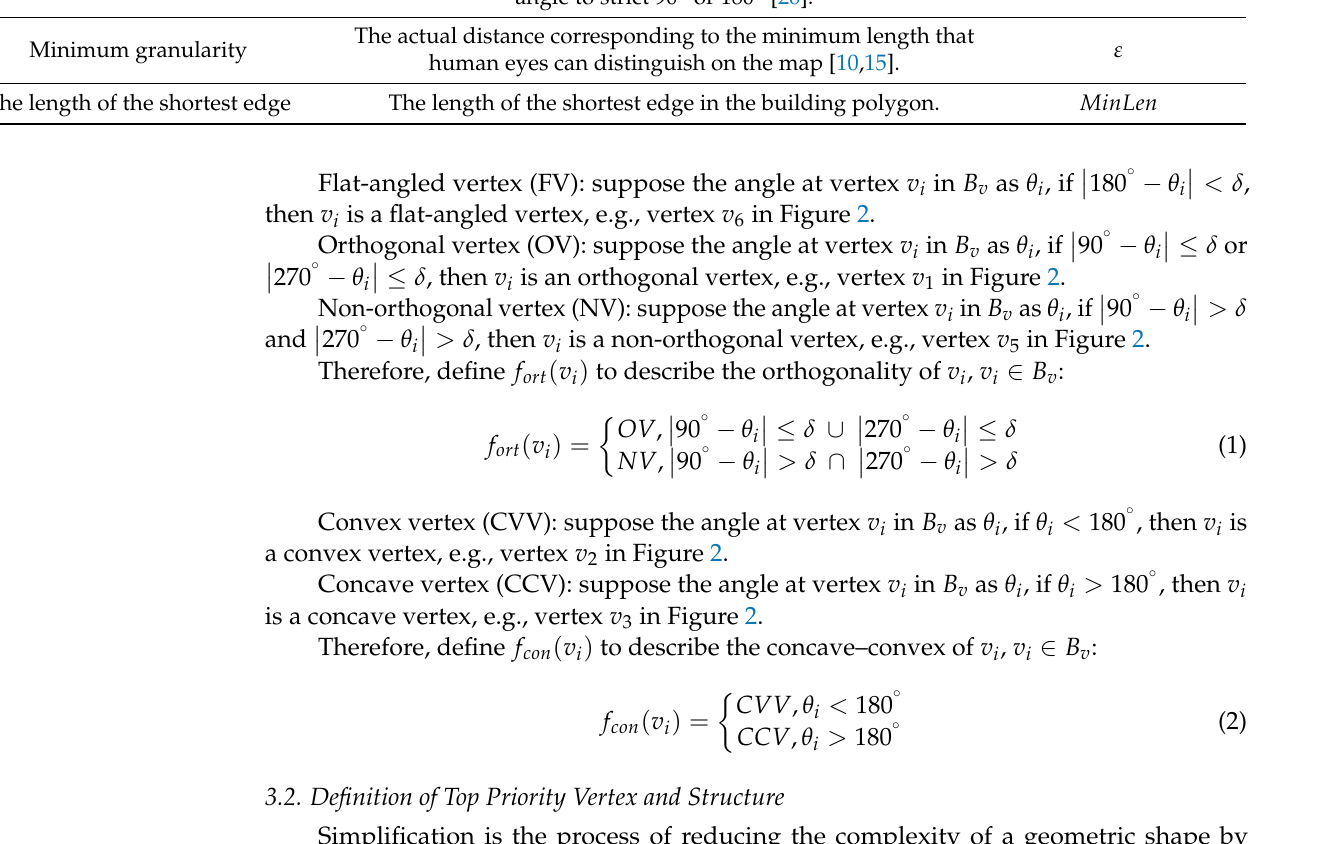
Table 1. Parameter description. Parameters Description Denoted A tolerance